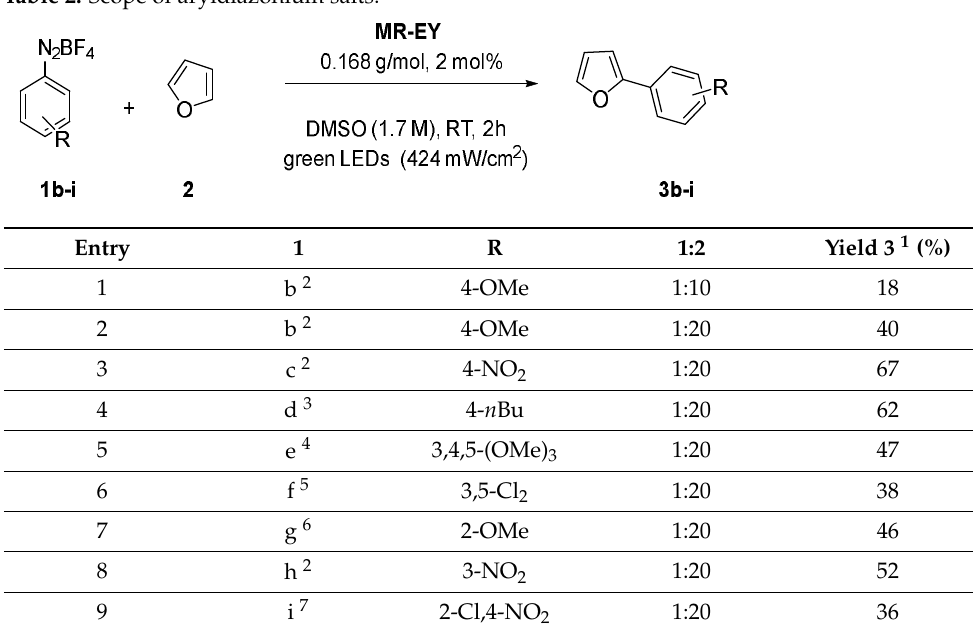
Table 2. Scope of aryldiazonium salts.